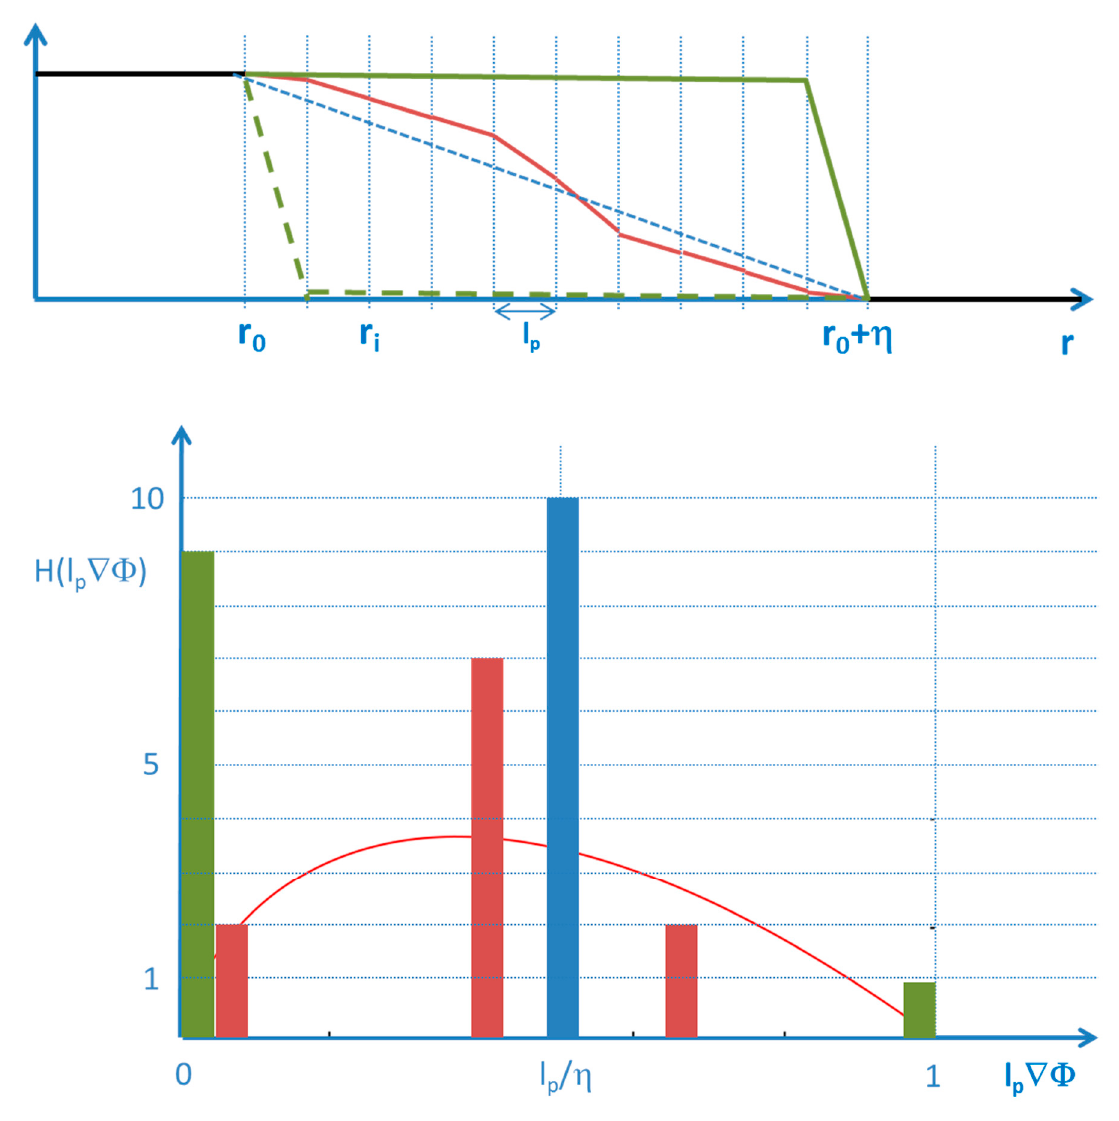
Figure 7. Possible shapes of the Φ function in the transition region: A constant average gradient (blue) leads to an extremely narrow distribution of contrast being centered around l p / η . The green shapes lead to high counts for small contrast. The red shape leads to a broad distribution of small and high contrast values. An entropy type distribution of contrast x i ( N = 10): H ( x ) = − 10 x ln( x ) is indicated as the red-line